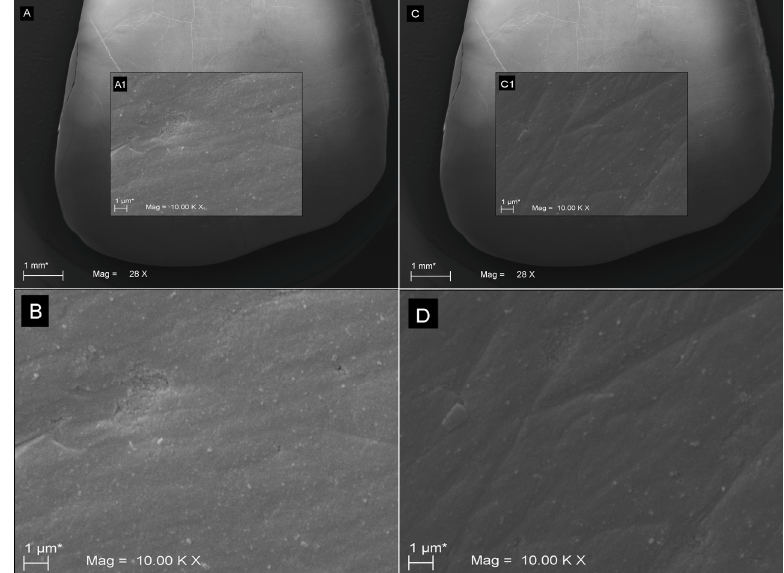
Figure 2. SEM images showing the human enamel surface alterations before and after the erythritol powder use (group B). The images show a lot of enamel irregularities: ( A ) 23 × magnification image of non-treated half part of tooth; ( B , magnification of A1 in A ) higher magnification (10,000 × ) of non-treated enamel. Meanwhile, the ( C ) 23 × and ( D , magnification of C1 in C ) 10,000 × demonstrate the enamel surface after treatment showing a reduction of enamel irregularities. However, a lot of surface depressions or grooves were also